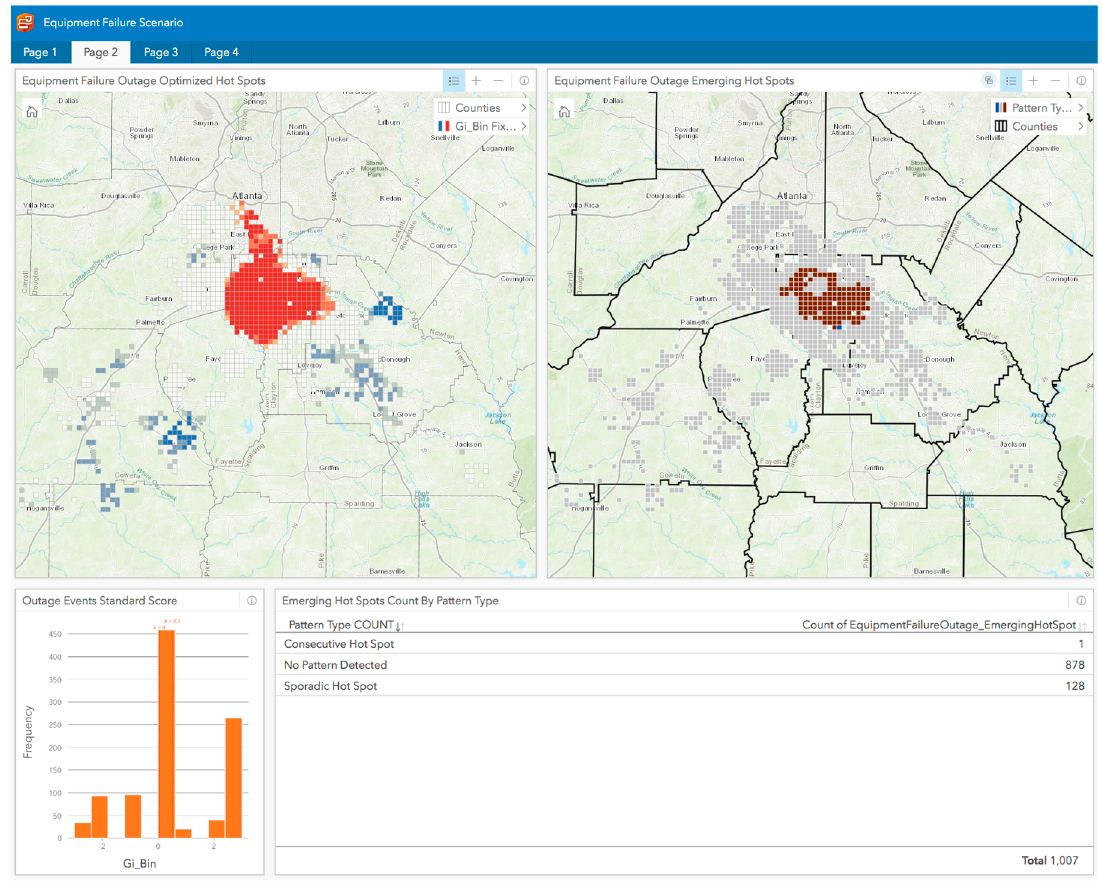
Figure 11. Challenge 3—Equipment Failure Scenario Workbook—Page 2.